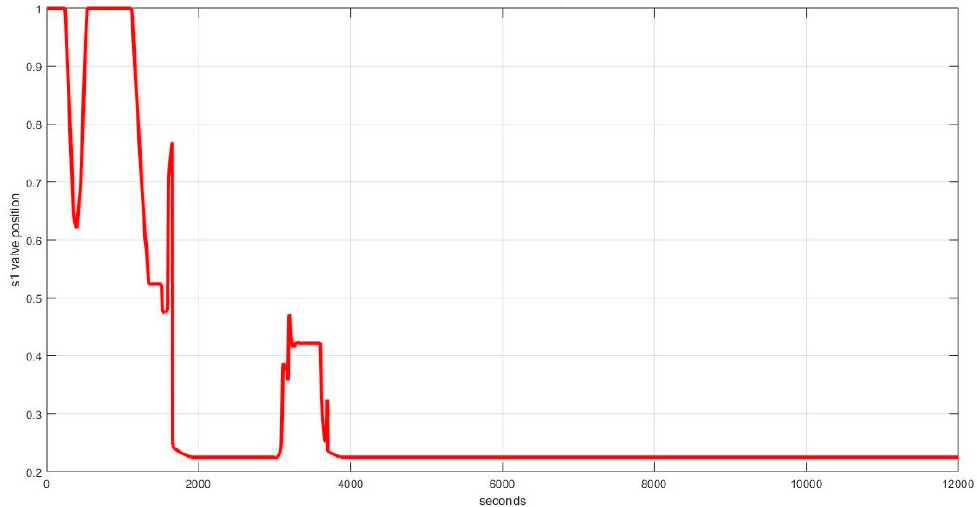
Figure 33. U1 control variable indicating the water inflow in case of a negative surge.